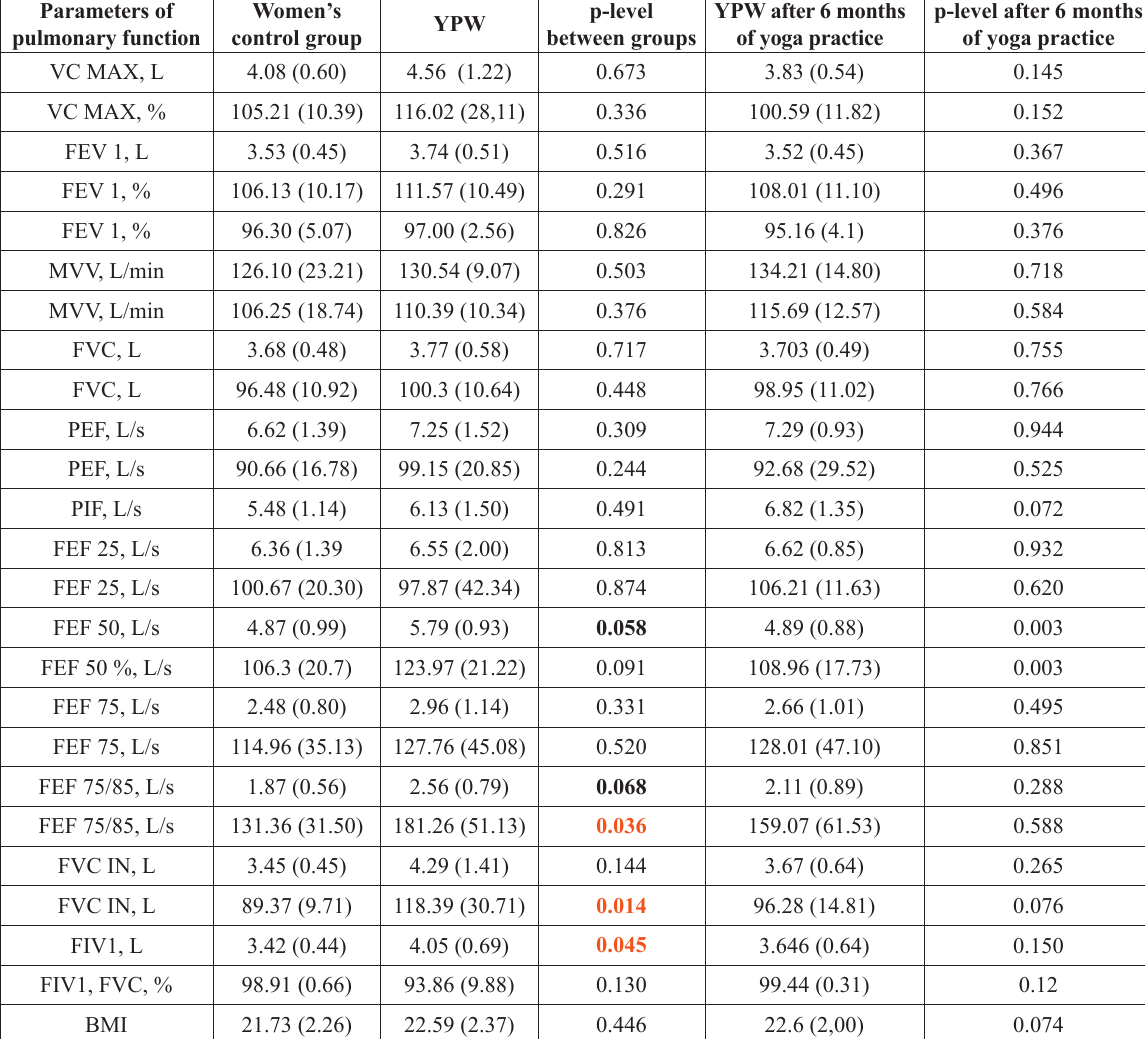
Table 1. Parameters of pulmonary function at rest in women in the control group and in those who were practicing yoga Parameters of pulmonary